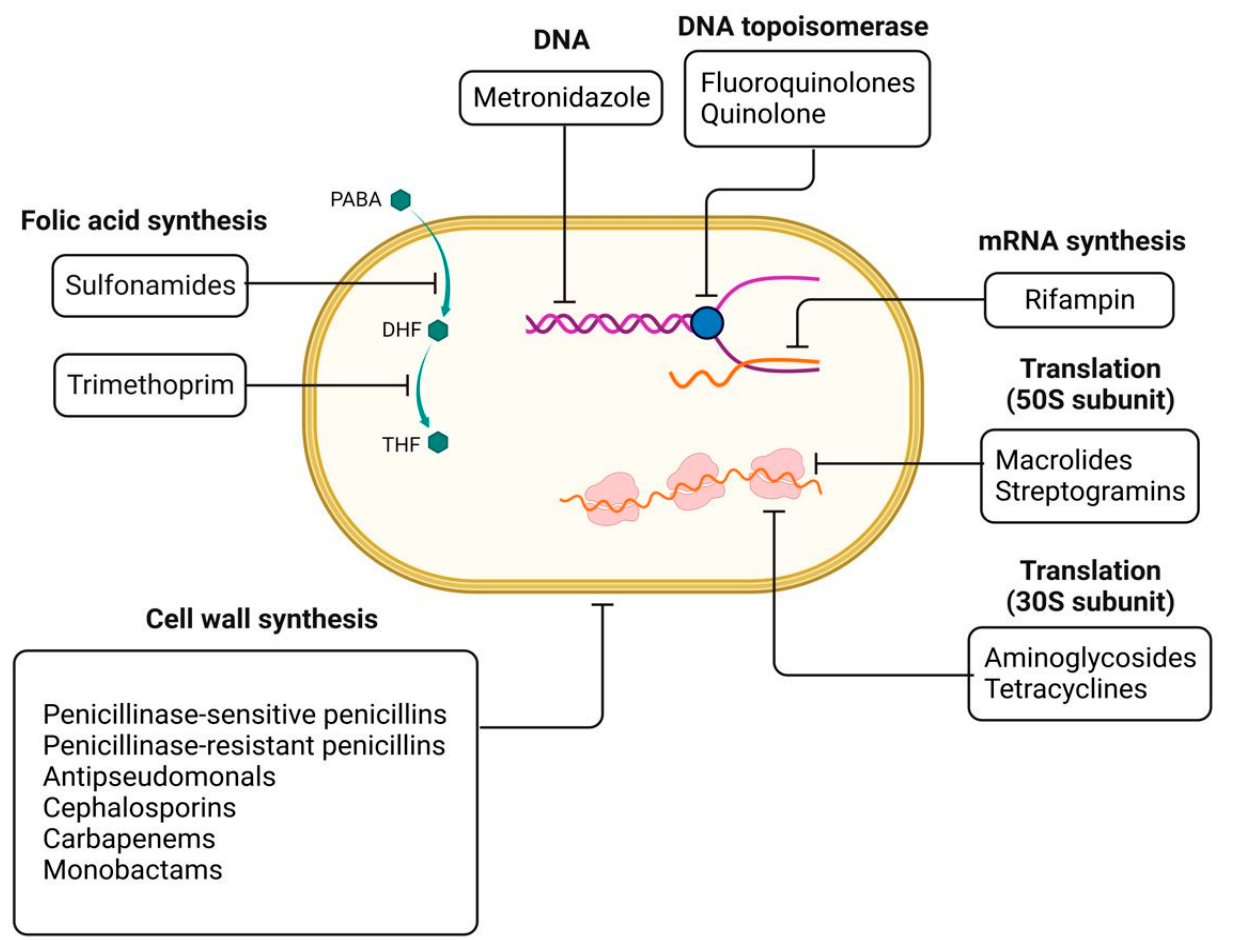
Figure 2. Antimicrobial therapy strategies.